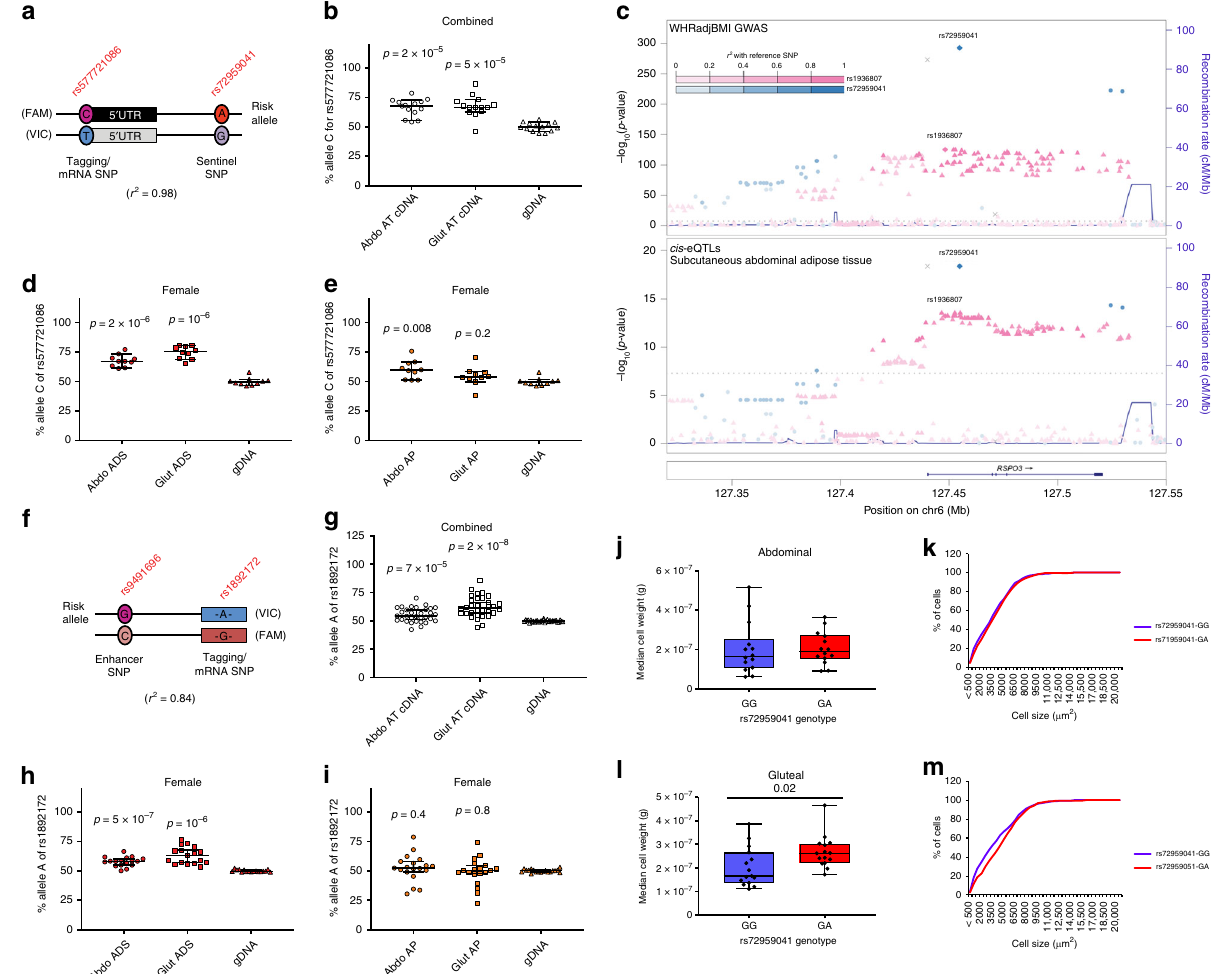
Fig. 1 Allelic expression imbalance of RSPO3 and histological studies in abdominal and gluteal AT. a Schematic illustration showing alleles of the sentinel SNP rs72959041 and the tagging SNP rs577721086. b Allelic expression analysis of RSPO3 transcripts was performed by qRT-PCR in abdominal and gluteal AT cDNA from 14 heterozygous carriers at rs72959041 (seven females, seven males). The proportion of total cDNA and gDNA containing the (WHR-increasing) rs577721086-C allele ( r 2 = 0.98 with rs72959041-A) is quanti fi ed on the y -axis. Error bars are median values with 95% con fi dence intervals. Statistical signi fi cance was assessed by two-tailed paired Student ’ s t -tests versus gDNA. c RSPO3 WHRadjBMI GWAS signals co-localise with subcutaneous adipose cis-eQTLs. d , e Allelic expression of RSPO3 transcripts were analysed in abdominal and gluteal isolated adipocyte (ADS) ( d ) and cultured AP ( e ) cDNAs from ten heterozygous female carriers at rs72959041 as in b . f Schematic illustration showing alleles of the enhancer SNP rs9491696 and the tagging SNP rs1892172. g – i Allelic expression analysis of RSPO3 in g abdominal and gluteal AT cDNA from 32 individuals (15 females, 17 males) and in h abdominal and gluteal ADS and i cultured AP cDNA from 17 and 19 females, respectively, who are heterozygous at rs9491696. All individuals selected are homozygous for the rs72959041-G (non-risk) allele. The proportion of cDNA and gDNA containing the WHRadjBMI-increasing rs1892172-A allele ( r 2 = 0.84 with rs9491696-G) is quanti fi ed on the y -axis. Error bars are median values with 95% con fi dence intervals. Statistical signi fi cance was assessed by two-tailed paired Student ’ s t -tests versus gDNA. j – m Median adipocyte cell weight calculated from median cell area measured from j abdominal and l gluteal AT histological sections from 14 and 15 pairs, respectively, of age- and BMI-matched females grouped by rs72959041 genotype. Cumulative frequency distribution of the adipocyte cell-surface area are shown for abdominal ( k ) and gluteal ( m ) AT. More than 250 cells were measured for each biopsy. Box and whisker plot: centre line, median; box limits, upper and lower quartiles; and whiskers, maximum and minimum values. Statistical signi fi cance was assessed by a two-tailed Wilcoxon signed-rank test. Source data are provided as a Source Data fi associated with differential AT RSPO3 expression. In age- and in AP biology using immortalised APs generated from paired percent fat mass-adjusted partial correlations, gluteal AP RSPO3 abdominal (imAbdo) and gluteal (imGlut) fat biopsies from a expression correlated negatively with gynoid and leg fat mass healthy adult male 26,27 . Stable RSPO3 knockdown (KD) in these (Table 2). No correlations between abdominal AP RSPO3 mRNA cells (Fig. 3a) led to reduced imAbdo AP proliferation (Fig. 3b) levels or mature adipocyte RSPO3 expression and fat distribution and enhanced adipogenesis in both imAbdo and imGlut cells were detected in this cohort. (Fig. 3c – f). Despite identical percentage KD (~ 45%) the pro- adipogenic effect of RSPO3-KD was more pronounced in imGlut versus imAbdo APs. RSPO3-KD in primary APs from a female RSPO3 modulates AP and adipocyte biology . After mapping the subject recapitulated these fi ndings although, adipogenesis was only augmented in gluteal cells (Fig. 3g – j). Finally, RSPO3-KD in expression pro fi le of RSPO3 in human AT we investigated its role